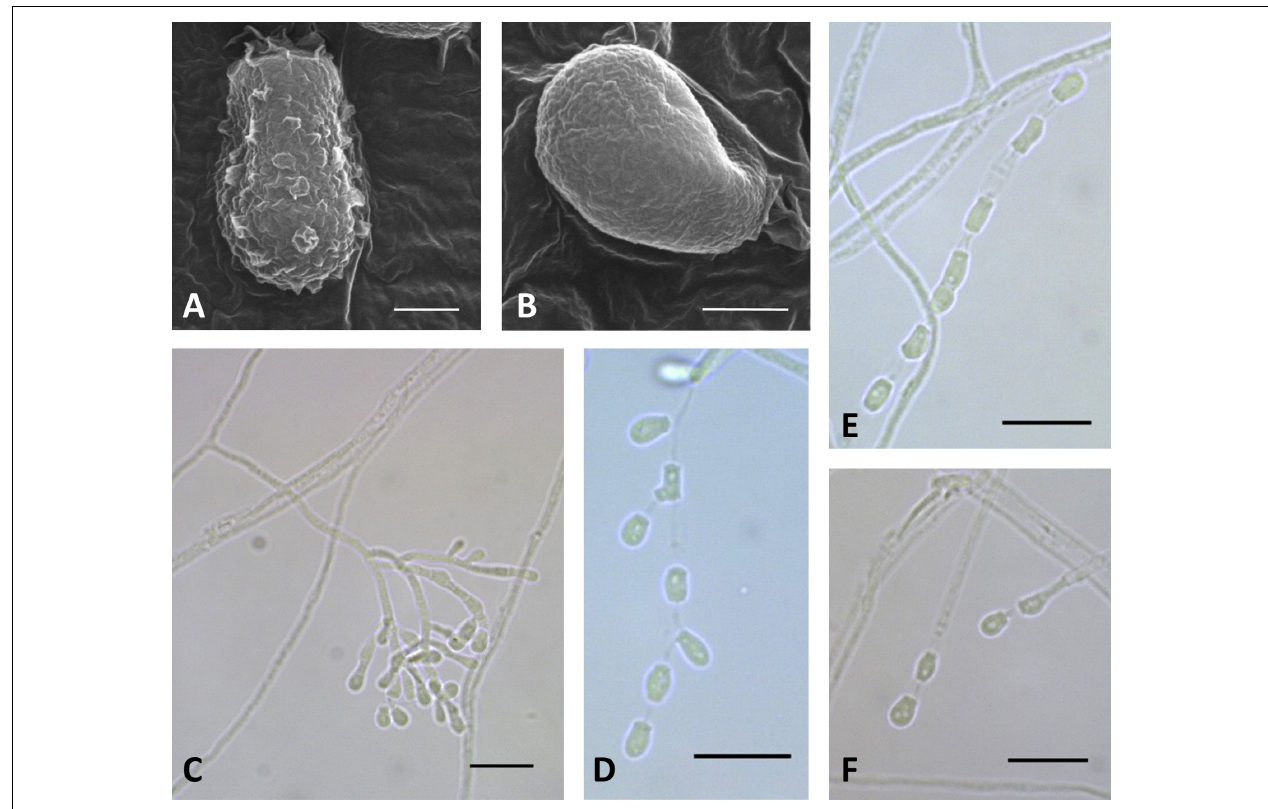
FIGURE 5 | Microscopic analysis of Pseudogymnoascus australis sp. nov. Conidia (A,B) ; Conidiophore (C) ; Fertile hyphae bearing arthroconidia and aleurioconidia, sessile, or stalked (D,E,F) . In panels (A,B) , the structures were observed using transmission electron microscopy, while in panels (C–F) , light microscopy was used. Scale bars = 1 µ m (A,B) , 10 µ m (C–F) .